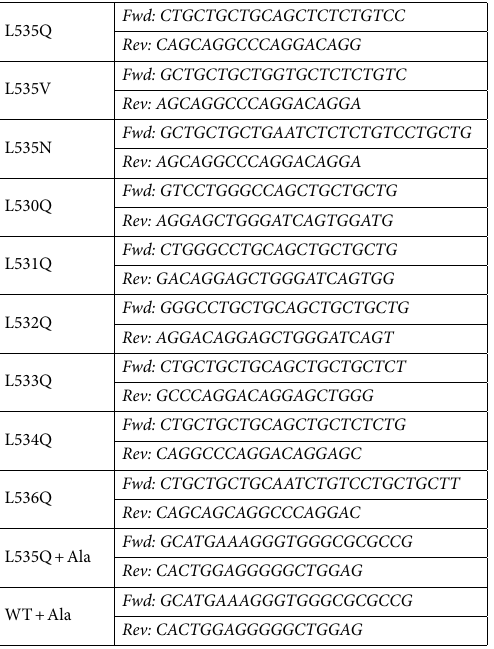
Table 1. Primers list for